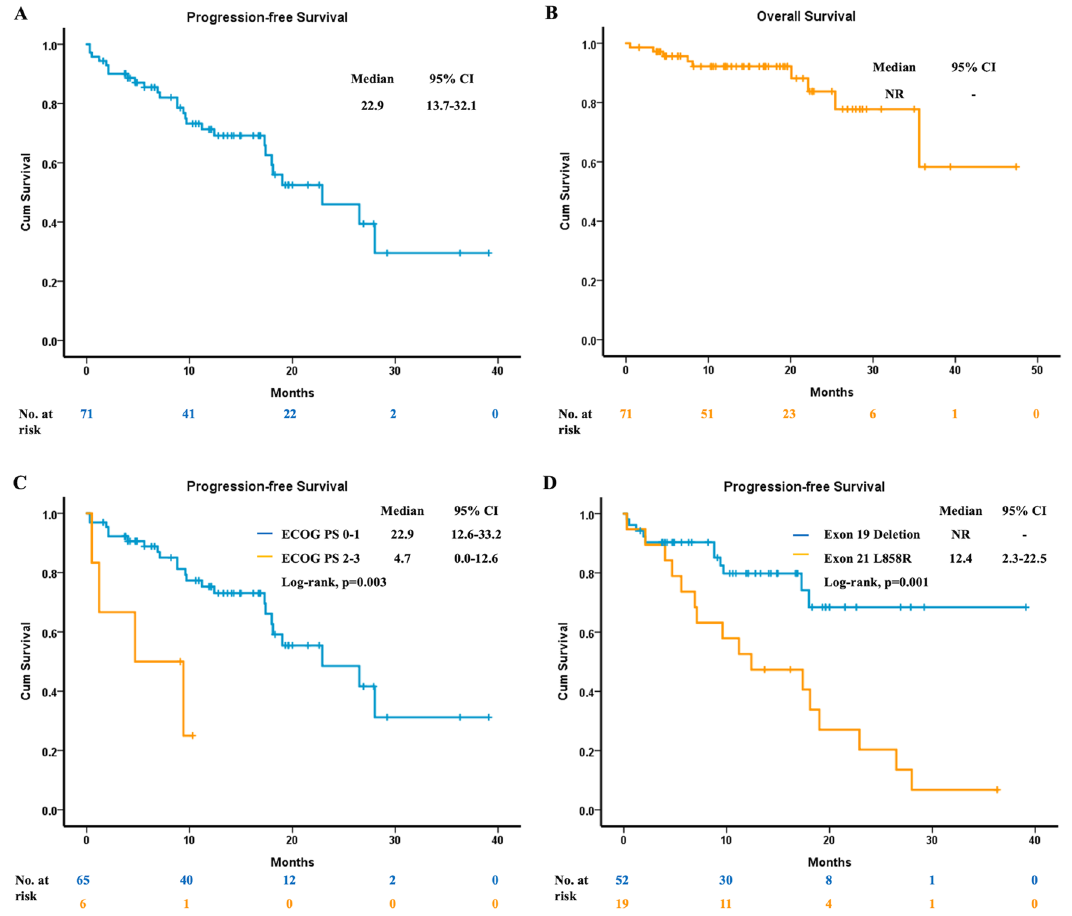
Figure 2. The clinical efficacy of osimertinib in patients with PD-L1 expression reports. ( A ) The median PFS. ( B ) The median OS. ( C ) The median PFS of patients with different ECOG PS. ( D ) The median PFS of patients with different baseline EGFR mutation status. PD-L1, programmed death-ligand 1; PFS, progression-free survival; OS, overall survival; ECOG PS, Eastern Cooperative Oncology Group performance status; EGFR, epidermal growth factor